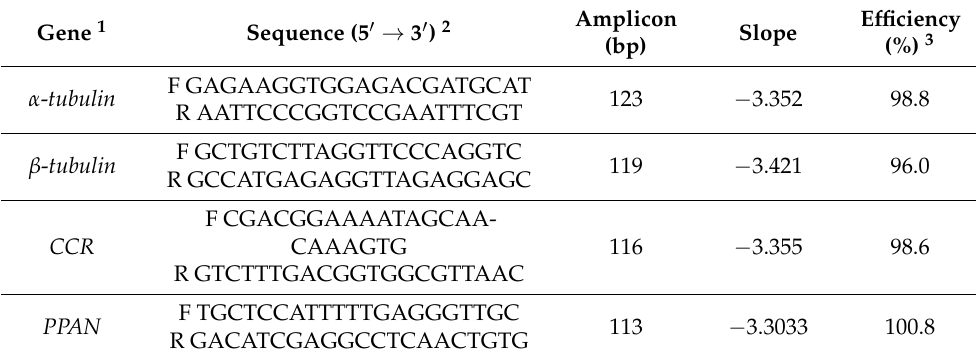
Table 1. Primer sets used to calculate the relative α and β - tubulin gene copy number by qPCR in trifluralin-resistant and susceptible A. palmeri